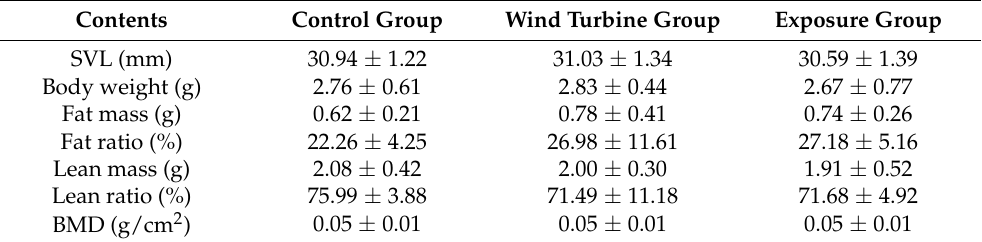
Table 2. The comparison of snout-vent length (SVL), body weight, fat content, lean body content, and bone mineral density (BMD) between field investigation groups (control and wind-turbine group) and noise exposure conditions group to identify the differences of basic physical conditions. All contents were not significantly different ( p > 0.05) according to a one-way ANOVA